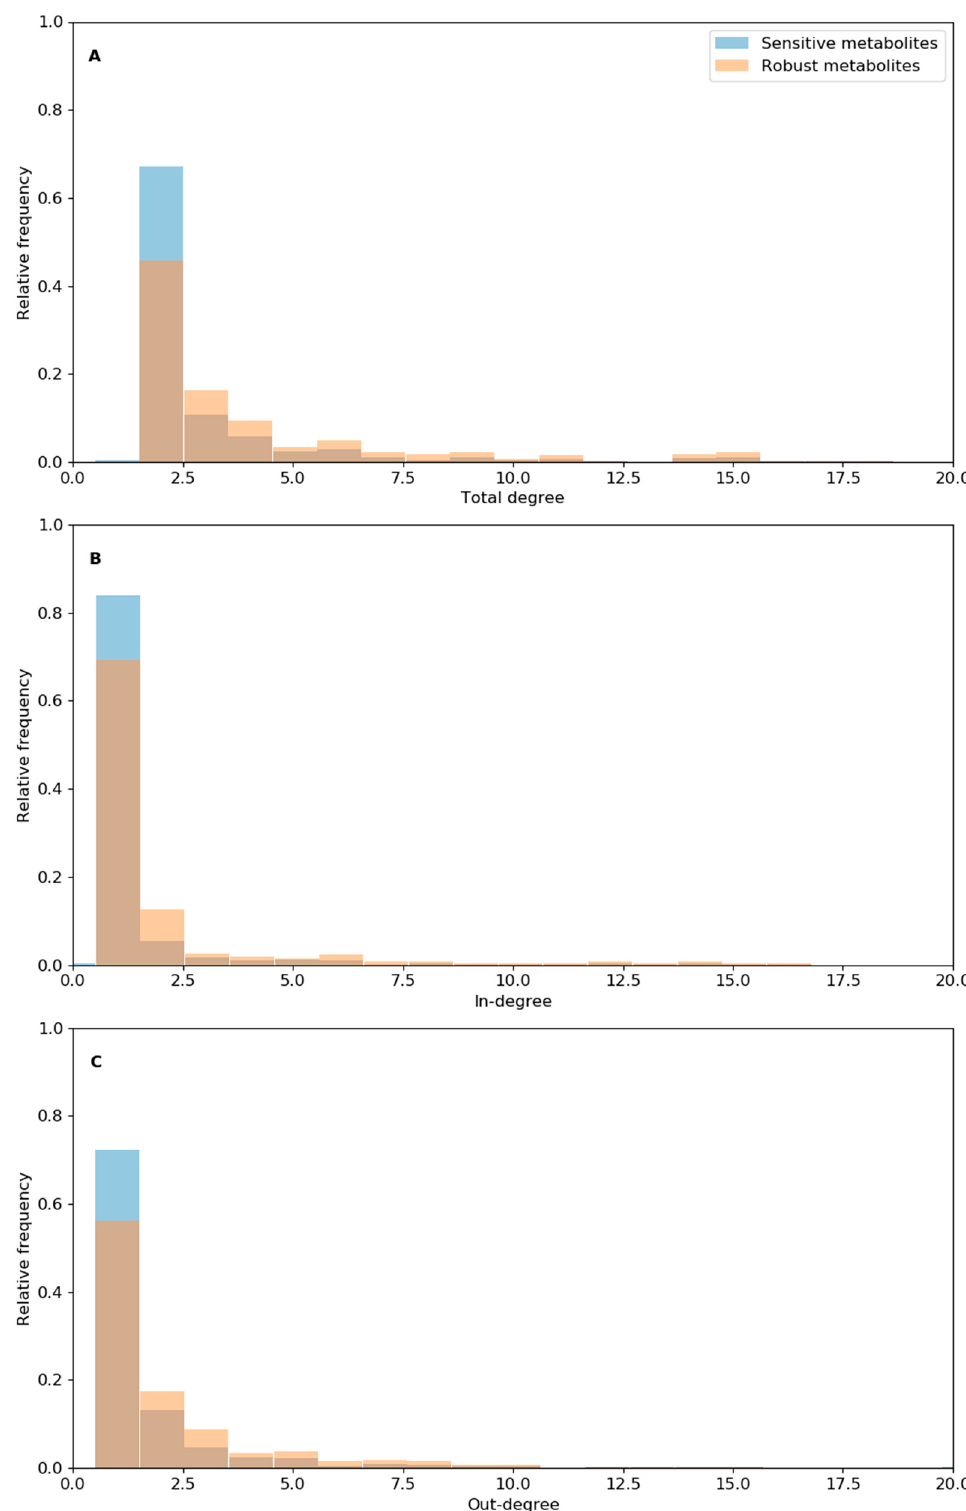
Figure 4. Relative frequency histogram of total degree ( A ), in-degree ( B ), and out-degree ( C ) for the metabolites involved in sensitive reactions (sensitive metabolites) or robust reactions (robust metabolites). “Total degree” refers to the total number of reactions connected per metabolite, “in-degree” refers to the number of reactions producing a metabolite, and “out-degree” is the number of reactions using a metabolite as the substrate. The X-axis is set to values smaller than 20. Full data are available in Supporting Information.